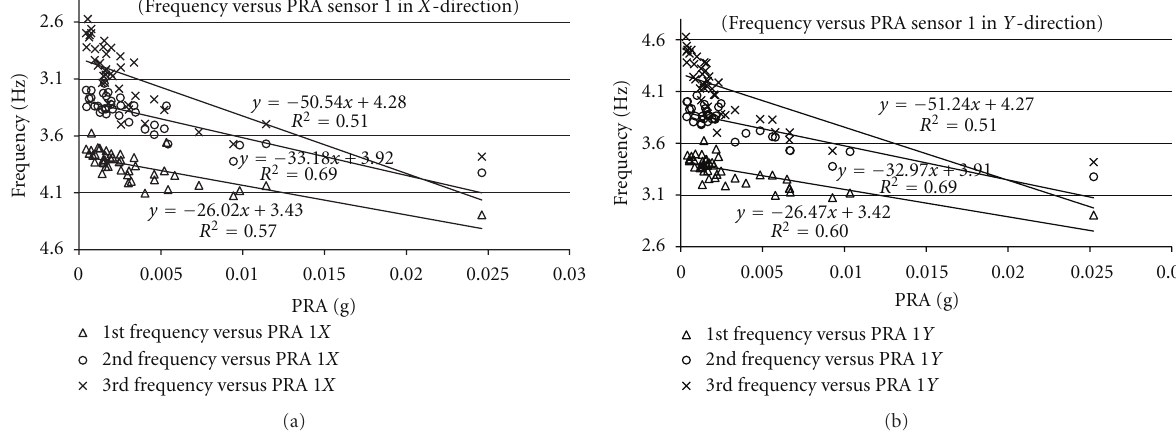
Figure 12: First three modal frequencies of building B for pseudoflexible base case versus PRA of sensor 1: (a) X -direction and (b) Y - direction.